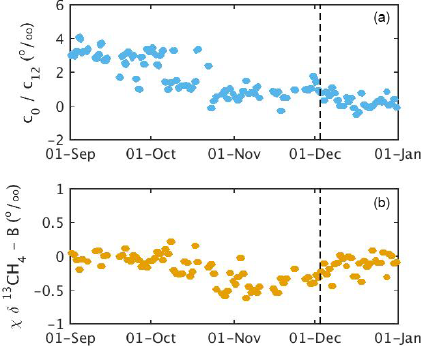
Figure 8. Effect of each of the calibration coefficient terms for the south tower for September–December 2016 for the optimized cal- ibration scheme. The terms c 0 (a) and χ (b) in Eq. (3) are time- dependent drift terms. Note the differing scales. An improved cal- ibration tank sampling strategy was implemented on 3 December 2016 (indicated by vertical dashed lines).